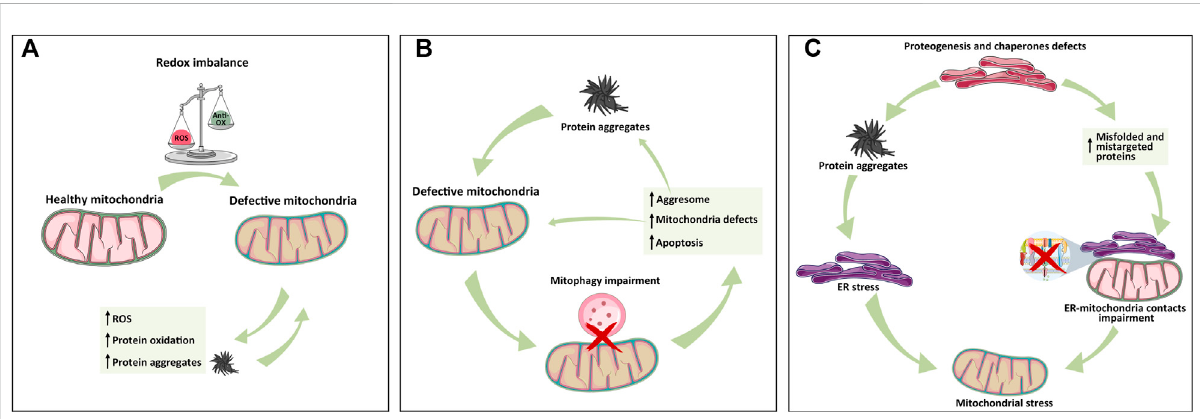
FIGURE 2 MitochondrialrelationshipwithERandlysosomeinproteinaggregateformation. (A) Mitochondria-dependentredoxequilibriumcanbealtered by endogenous or extracellular cues, leading to the accumulation of ROS and protein aggregates that, in turn, exacerbate the vicious circle of mitochondria impairment and protein aggregation. (B) Following protein aggregate accumulation and mitochondrial impairment, lysosome – mitochondria communication for mitophagy is impaired, leading to mitochondria stress, activation of aggresome, protein aggregates formation, and apoptosis activation whether mito/autophagy cannot rescue the cell. (C) ER is the hub of protein synthesis. Defects in proteogenesis, chaperone activity, and signal recognition particles (SRPs) increase the accumulation of unfolded protein and thus aggregates, triggering ER stress, and MAM alteration, all of which cause mitochondrial defects. As depicted in panel A, the exacerbation of protein aggregates formation leads to organelle failure. The simpli fi cation of these inter-organelles relations into these three panels has the only aim of highlighting the individual contributions in a more complex and intertwined